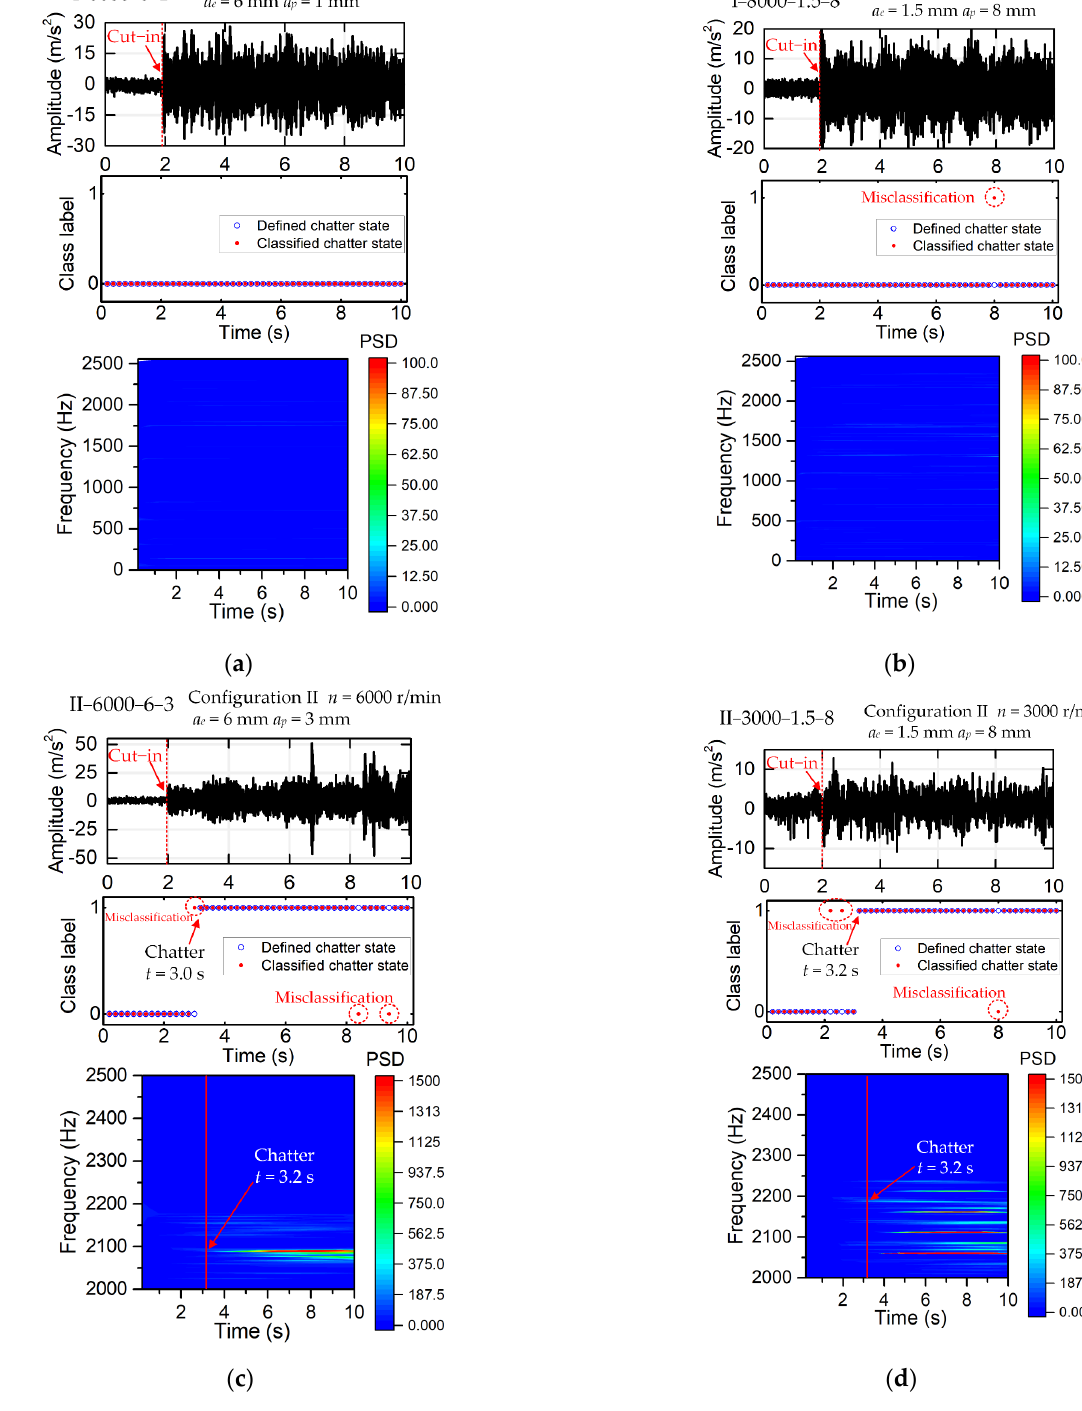
Figure 10. Detection results for: ( a ) I − 6000 − 6 − 1; ( b ) I − 8000 − 1. 5 − 8; ( c ) II − 6000 − 6 − 3; ( d ) II − 3000 − 1.5 − 8.